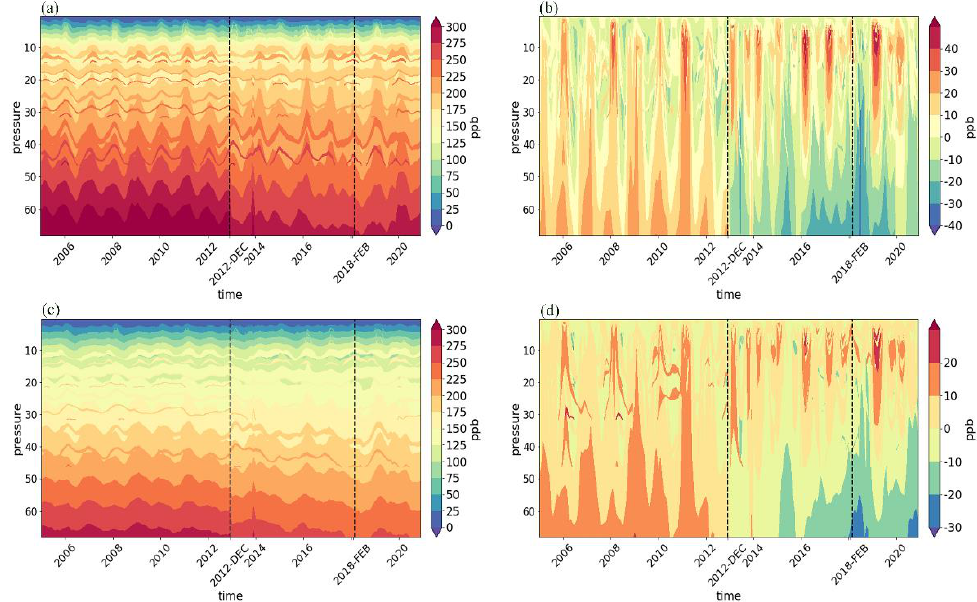
Figure 3. Temporal variation of N 2 O horizontal regional average concentration ( left ) and its anomaly ( right ) at all vertical pressure levels from 2005 to 2020 over the region of latitude of 23.5 ◦ S–23.5 ◦ N ( a , b ) and of 81.75 ◦ S–81.75 ◦ N ( c , d ).